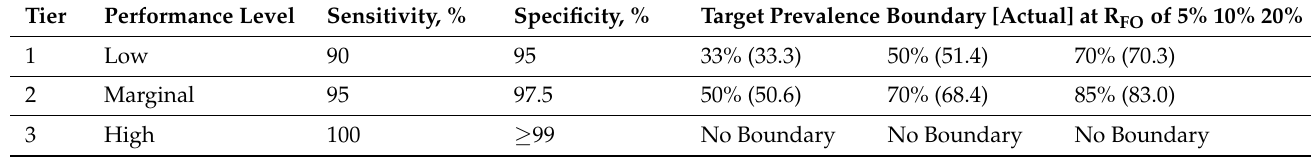
Table 2. Performance Tiers with Coordinated and Integrated False Omission Rates and Prevalence Boundaries Bracketing Community Immunity from 50% to